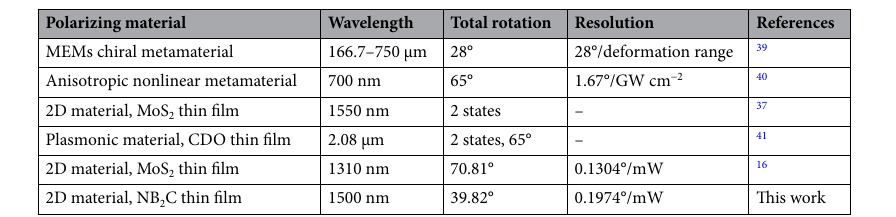
Table 1. Comparison of polarization modulator with different polarizing